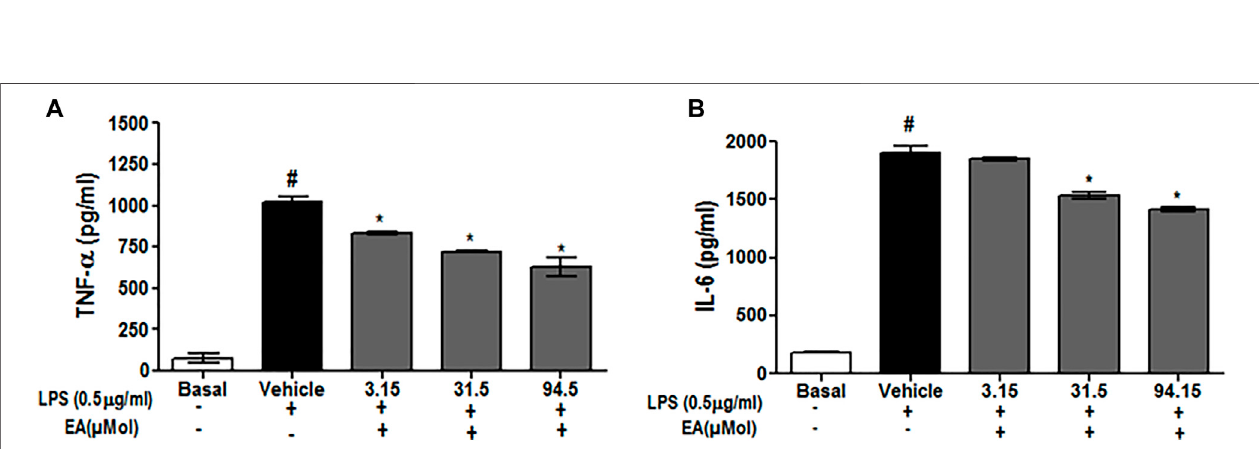
FIGURE 8 | Effect of EA on production of pro-in fl ammatory cytokine (A) TNF- α and (B) IL-6 in C6 microglial cells. Data are expressed as Mean ± SEM; P < 0.05; #Normal vs Vehicle treated; *Vehicle vs treatment; n (cid:1) 3.